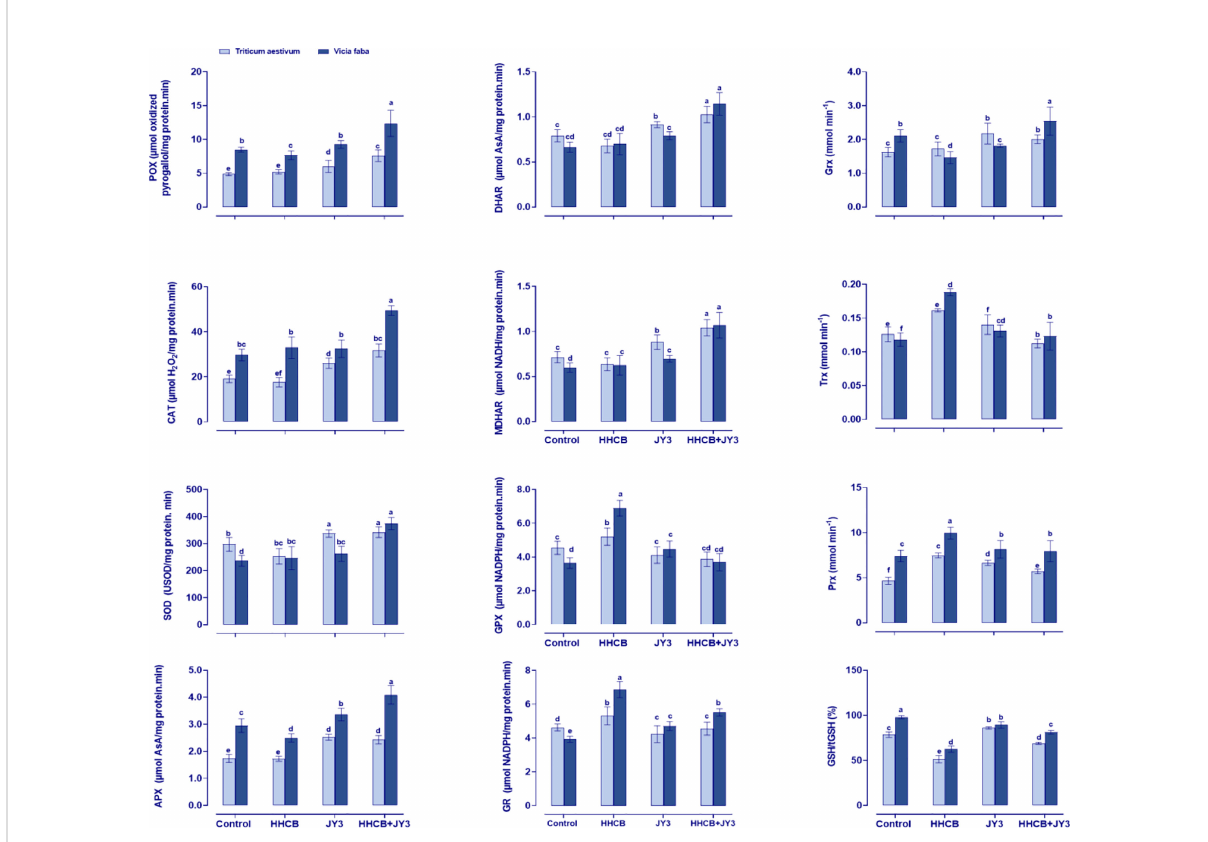
FIGURE 5 Effect of HHCB either alone or in combination with Rhodospirillum sp. JY3 on the antioxidant defense system of both wheat and faba beans. Three biological replicates were used to detect each value. The bars on the columns represent error bars (SE). One-way ANOVA test was used to determine the signi fi cant difference between the groups. Similar letters on the bars indicate no signi fi cant difference between treatments. SOD; Superoxide dismutase, APX; ascrobate peroxidase, POX; peroxidases, GPX; guaiacol peroxidases, CAT; catalase, MDHAR; monodehydro- ASC reductase, DHAR; dehydro ASC reductase, GR; glutathione reductase, and GST; glutathione-S-transferase, Grx: Glutaredoxin, Trx; thioredoxin and Prx;